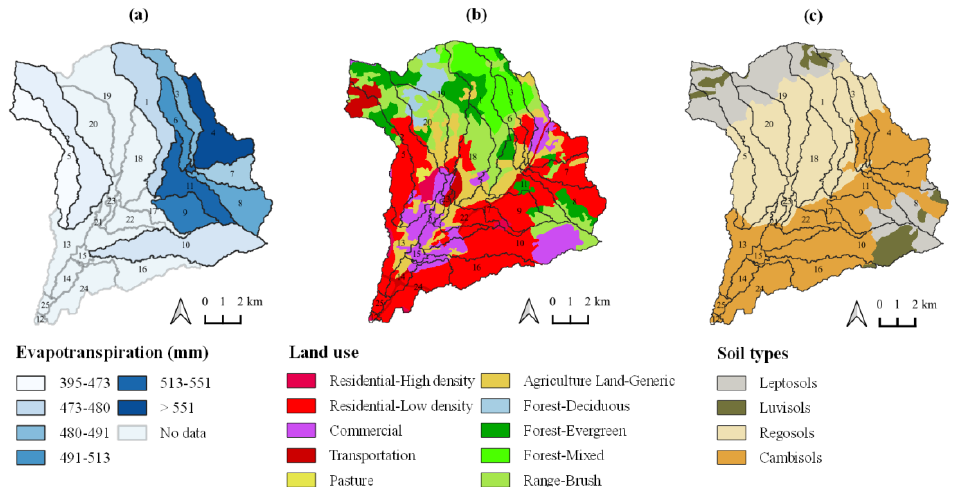
Figure 2. Kifissos River sub-basin ( a ) MODIS average annual evapotranspiration, ( b ) land use, and ( c ) soil types. The study area includes 25 sub-basins of which the sub-basin numbers (1 – 11) indicate the sub-basins used for actual evapotranspiration calibration.